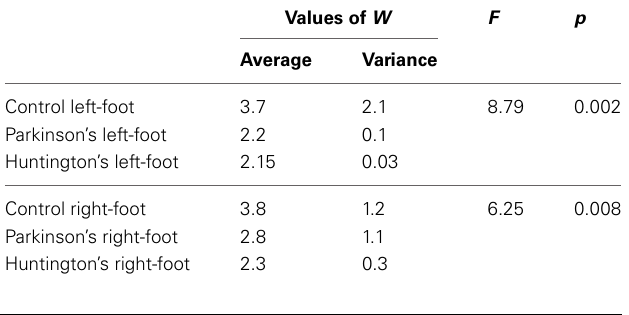
Table 1 | Mean values, Variance of multifractal width W (Equation 9), and ANOVA parameters F and p values for all three groups.